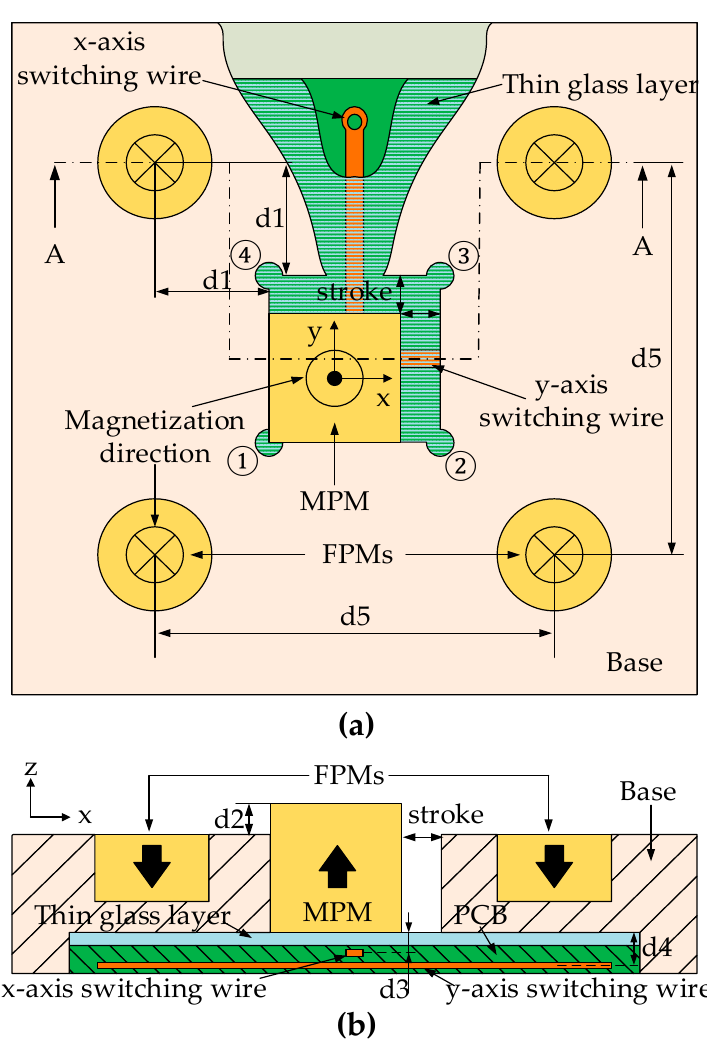
Figure 1. Elementary digital actuator. ( a ) Top view. ( b ) Cross section view A ‐ A. Table 1. Actuator Table 1. Actuator properties.